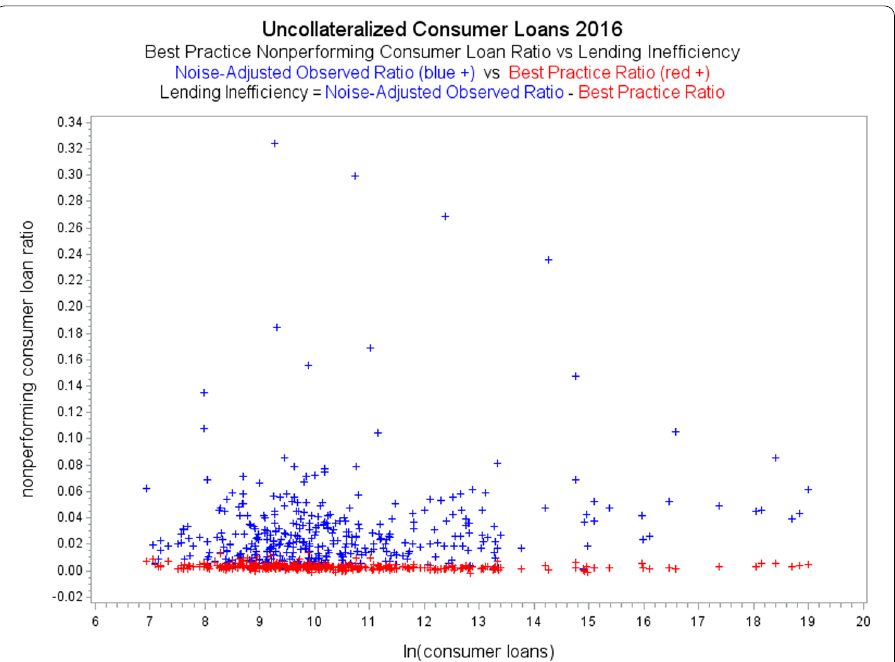
Fig. 3 Nonperforming consumer loan ratio, best practice ratio, and lending inefficiency: 2016, not controlling for the loan